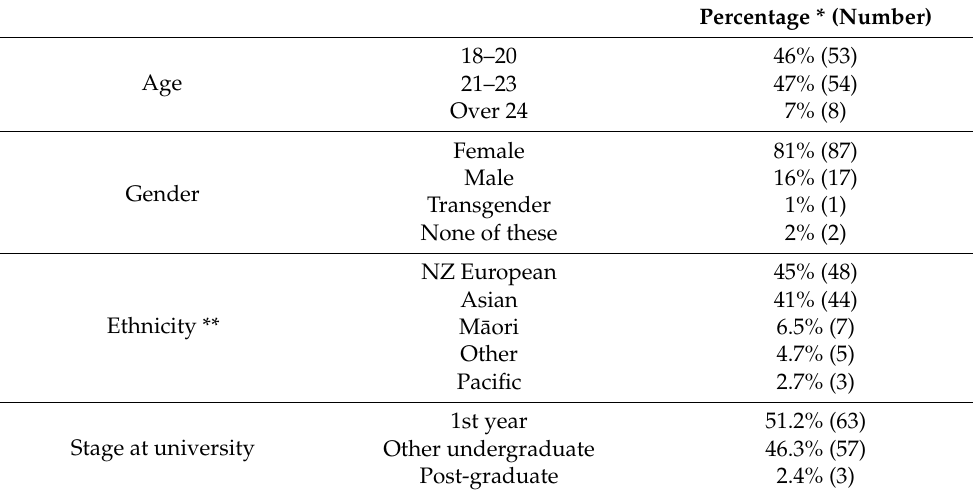
Table 3. Demographic characteristics of participants at baseline ( n = 124).